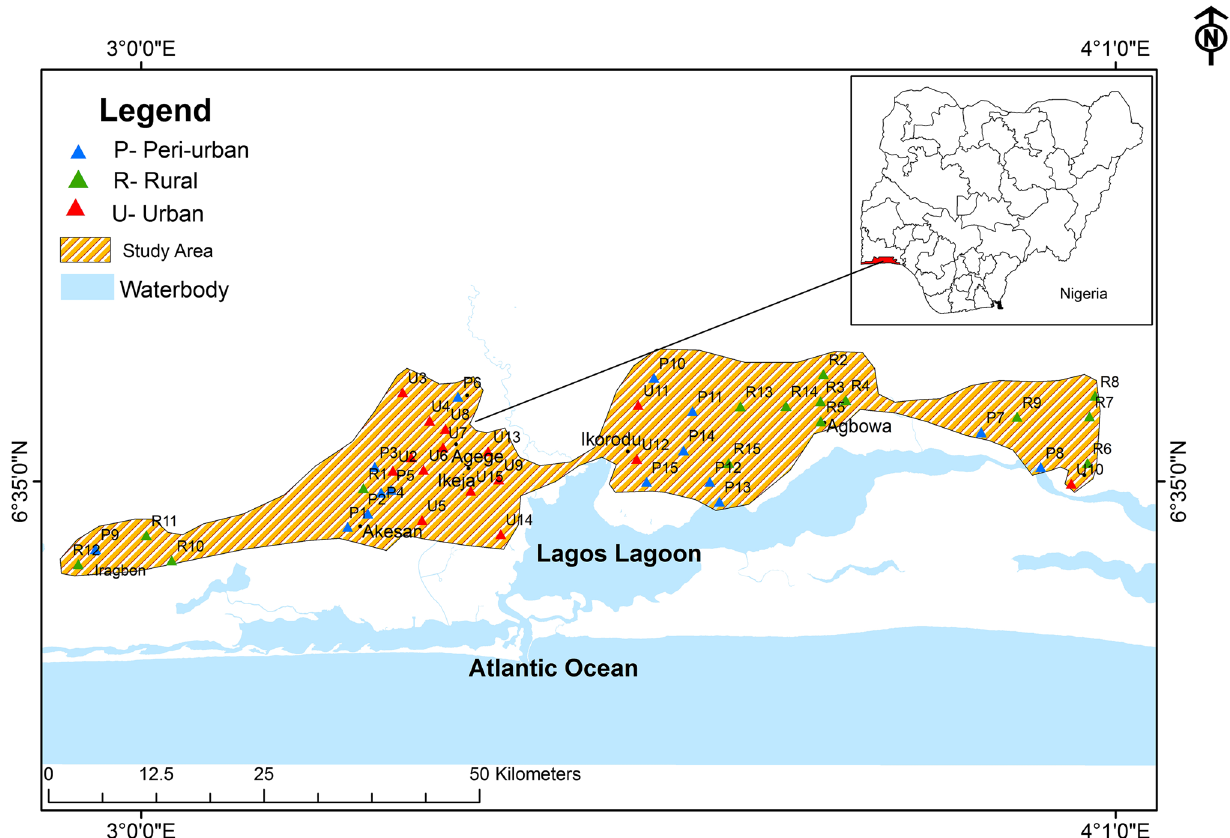
Fig. 2 The sampling